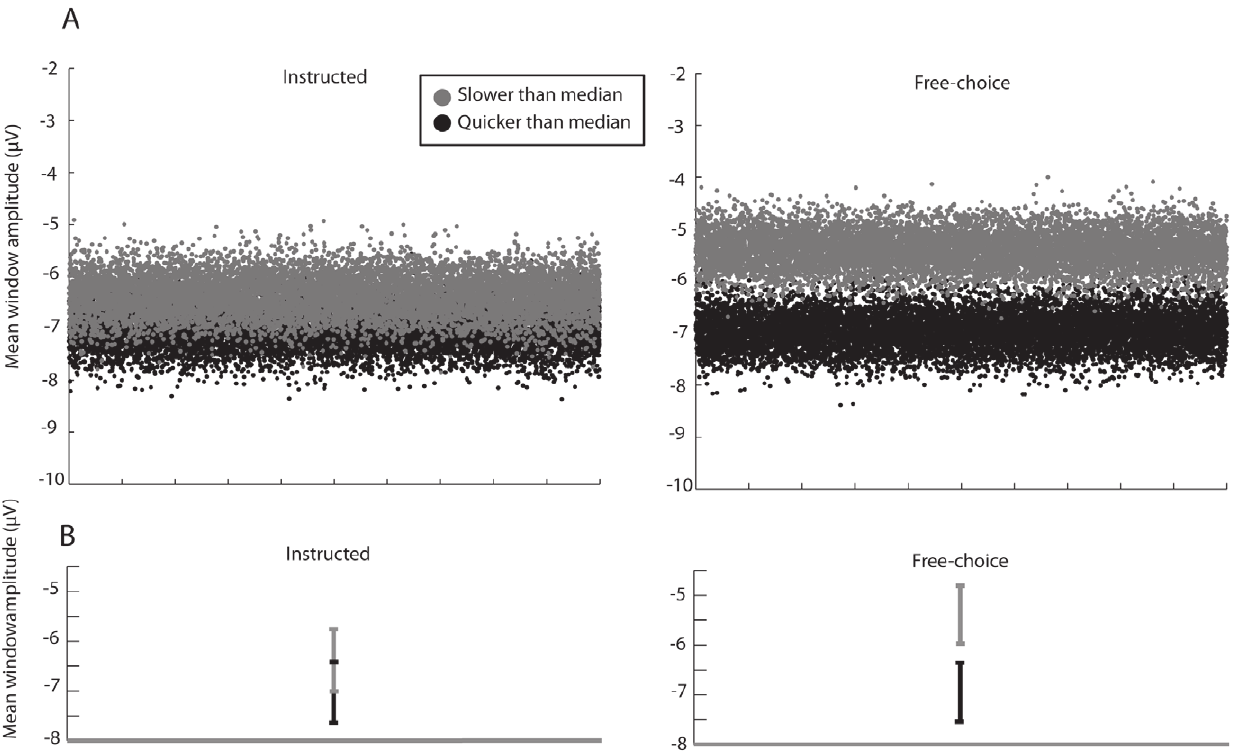
Figure 5. Control to account for differential trial numbers between conditions. Bootstrapping procedure to resample instructed trials, compensating for differences in numbers of each trial type. This procedure allows instructed and free-choice reactions to be classified based on reaction times. Results are shown for the interval of 2 150 to 0 ms prior to the onset of the visual cue, in electrode Cz A. The instructed rapid and delayed subsampled populations cannot be easily distinguished. In contrast, the free-choice rapid and delayed subsample populations are clearly distinct. B. 95% Confidence intervals for instructed and free-choice conditions. Note that while they are separate in the free choice conditions, they overlap in the instructed